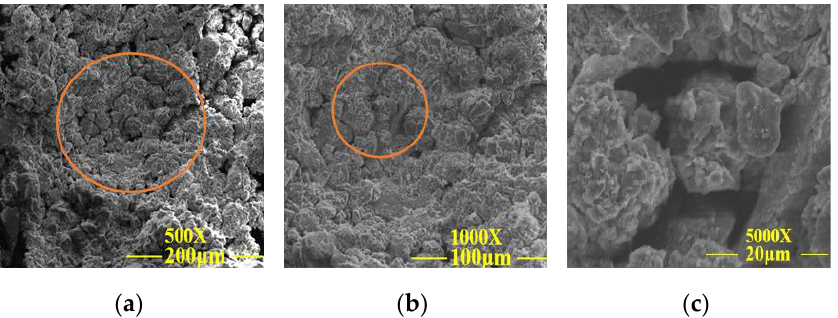
Figure 10. SEM images of the test group 6. ( a ) SEM analysis at a magnification of 500×; ( b ) SEM analysis at a magnification of 1000×; ( c ) SEM analysis at a magnification of 5000×.